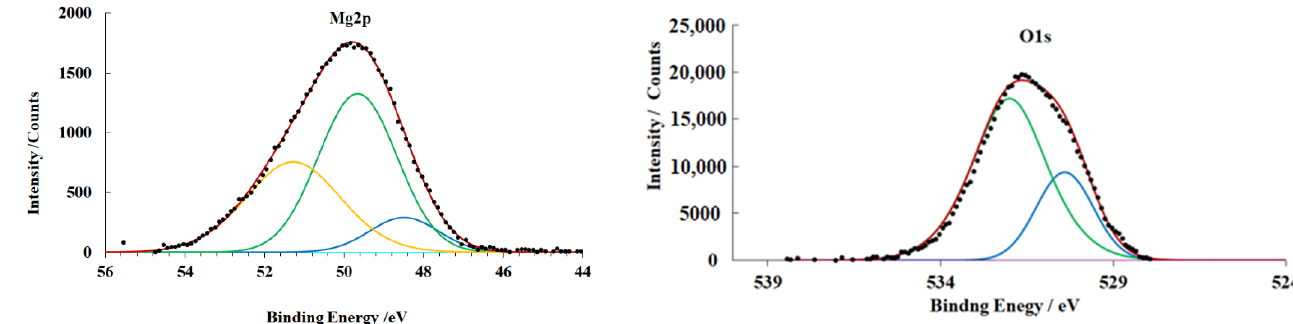
Figure 6. XPS spectra of magnesium alloy samples (preparation mode B ).